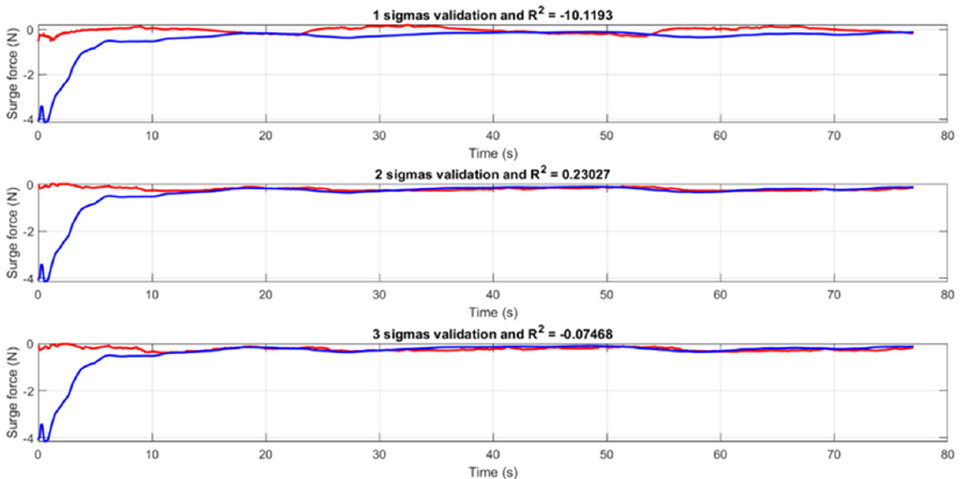
Figure 12. Results from the validation for surge motion with 20°-20° zigzag manoeuvre tests’ data.